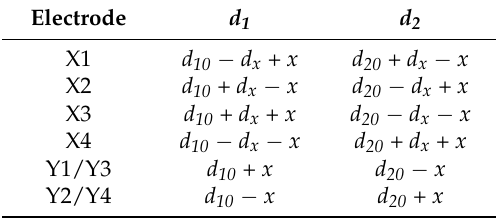
Table 2. Applied voltages on eight lateral electrodes.